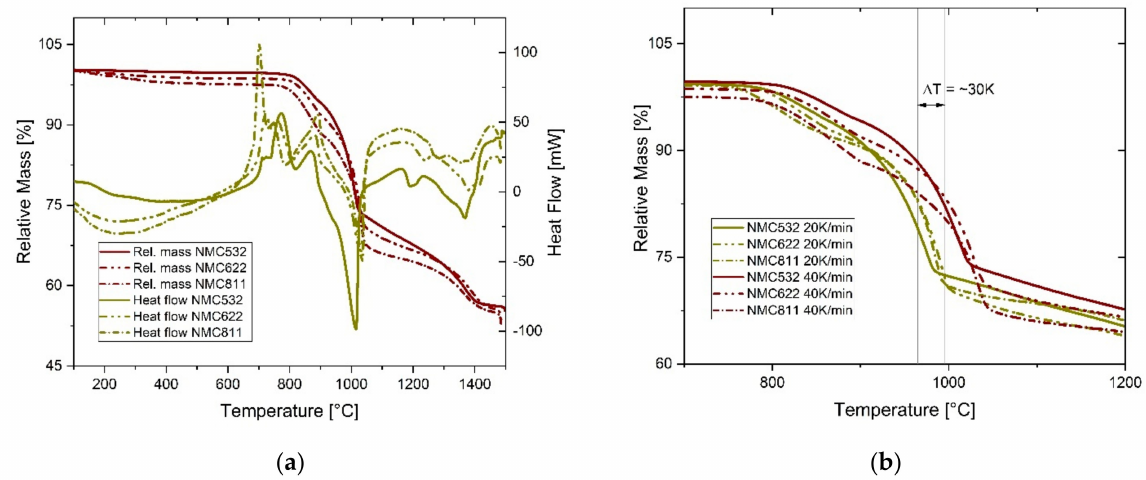
Figure 2. Results of thermogravimetric analyses and differential scanning calorimetry of NMC532, NMC622, and NMC811 with a coke addition of 25 wt.% each. ( a ) Curve of relative sample mass and the corresponding heat flow with a heating rate of 40 K/min. ( b ) Comparison of relative sample mass curves with heating rates of 20 and 40